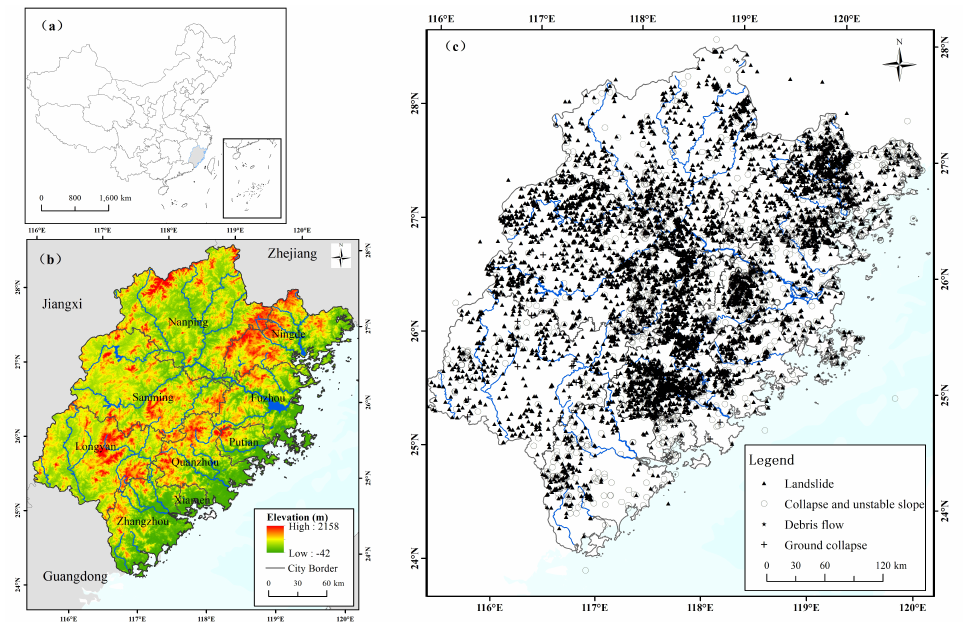
Figure 1. ( a ) Location of the study area in China; ( b ) a digital elevation model (DEM); ( c ) distribution of geological disasters in the study